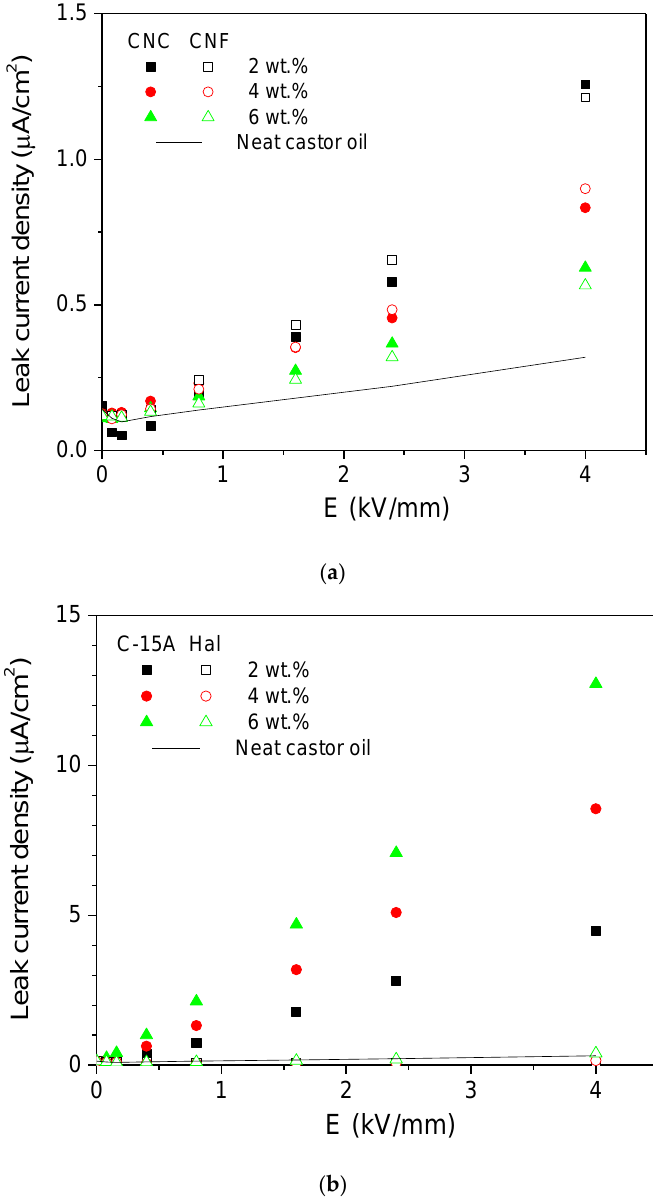
Figure 8. Electric field dependence of the leak current density for ( a ) the nanocelluloses and ( b ) the nanoclays dispersions in castor oil (neat castor oil included for the sake of comparison).